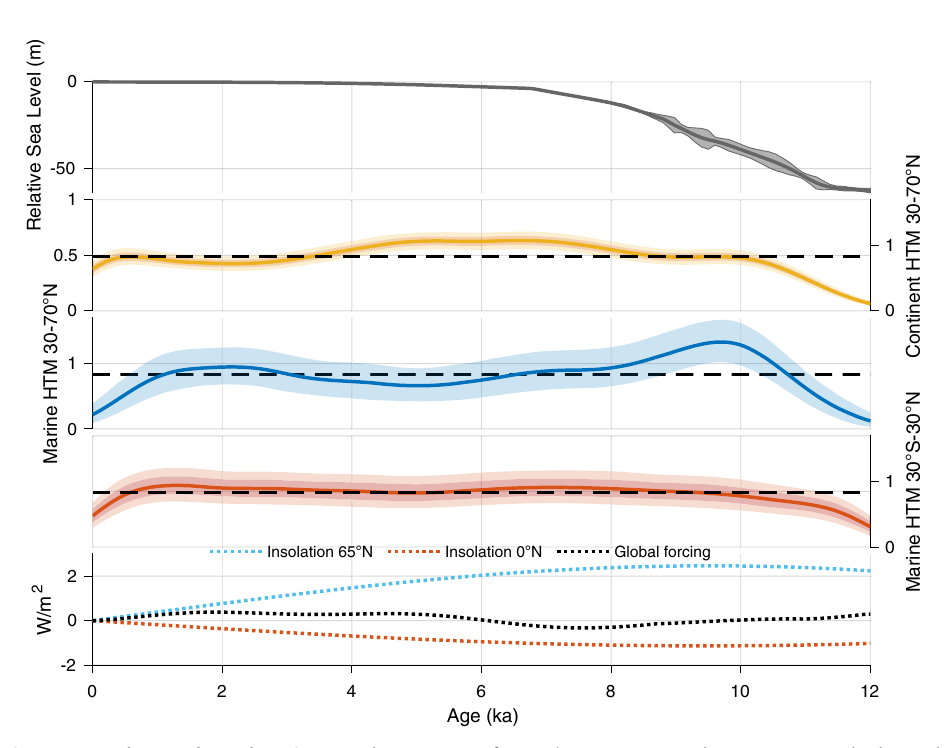
Fig. 3 | Climate forcing impact on Holocene Thermal Maximum. Relative sea level 47 ; Holocene Thermal Maximum (HTM) age probability density function between 30°N and 70°N over land and ocean, and between 30°S and 30°N in the oceans.Meanannualinsolationat65°Nandattheequatorandthesumofradiative